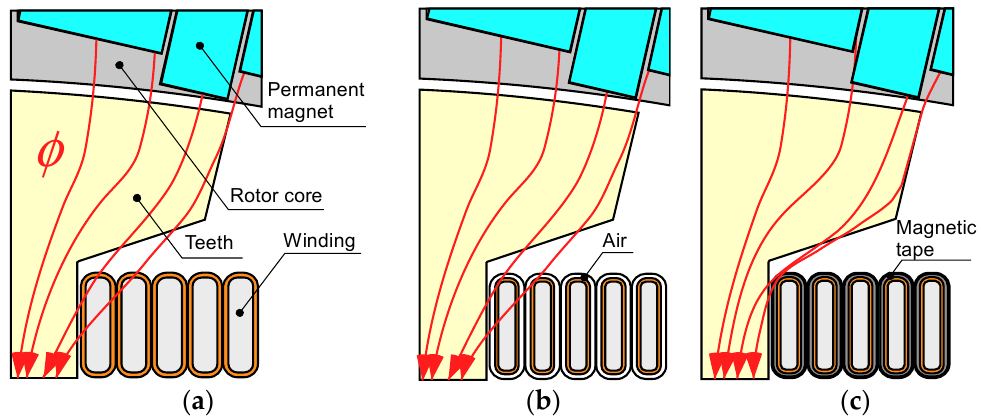
Figure 2. Magnetic flux path after installing the winding structure: ( a ) rectangular winding; ( b ) thin rectangular winding; ( c ) magnetic tape winding.